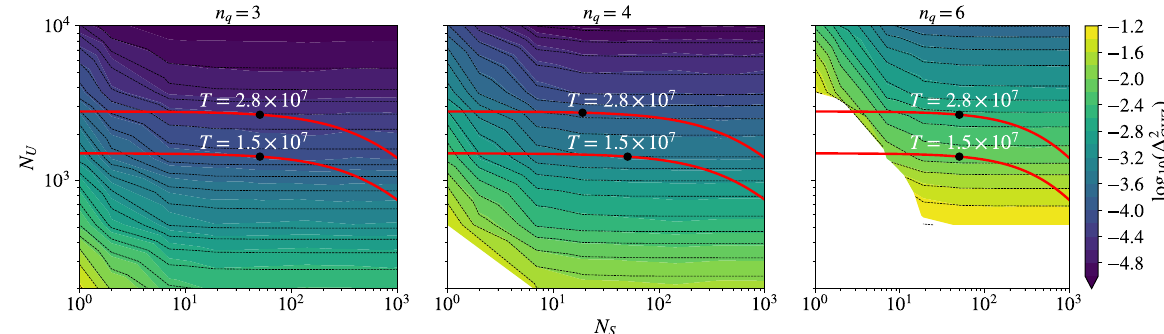
FIG. 6. Optimal choices of N U and N S for a given measurement budget for different numbers of qubits n q = 3, 4, 6. The color bar indicates the logarithm of the mean squared error (cid:5) 2 = ( c / N 2 )( 1 + c / N 2 ) . The red lines show the contours of fixed T = N (cid:5) 2 1 2 U GHZ S with the circles indicating the optimal choices of N U and N S . In the white region of the plot (cid:5) 2 problem and measurement budget regime, the optimal choices of N U and N S remain similar as we change the number of qubits.